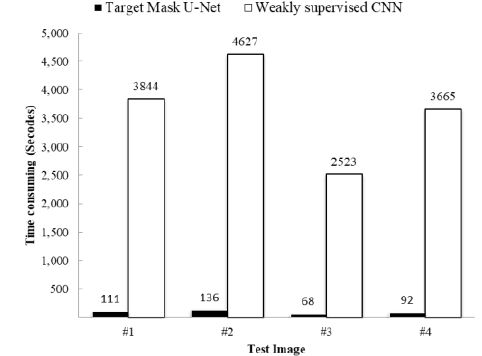
Figure 7. Time consuming of two detection methods